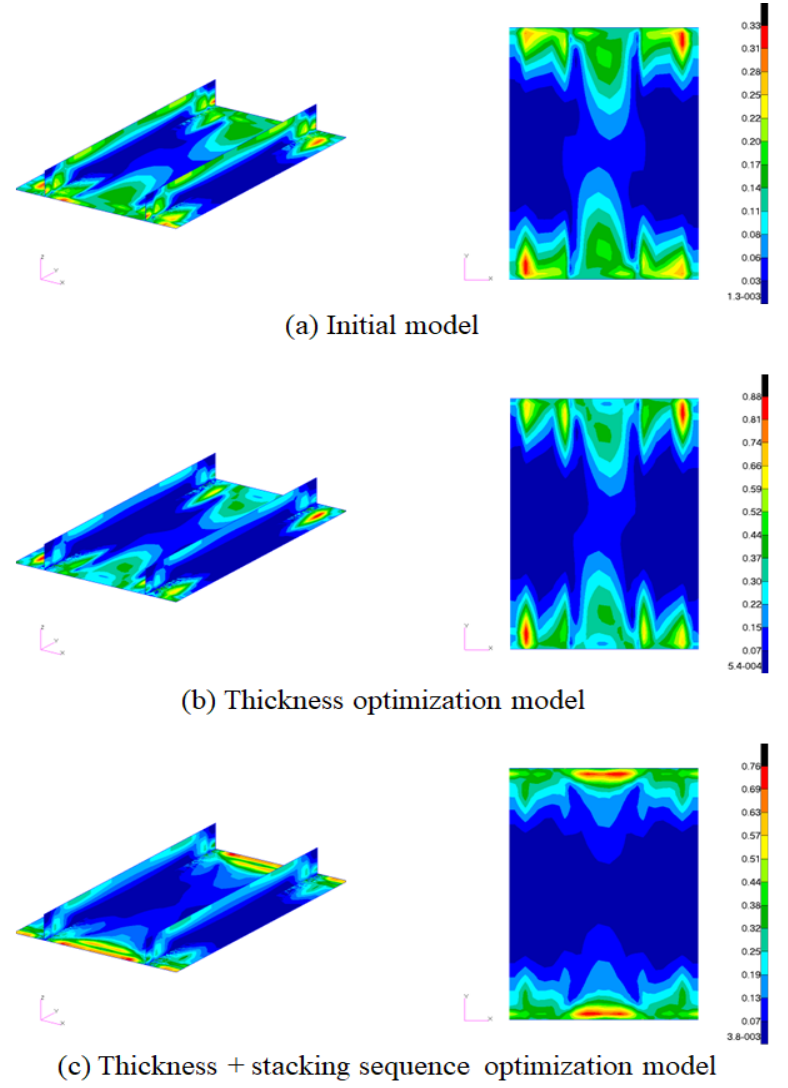
Figure 14. Comparison of each model’s failure index result s.